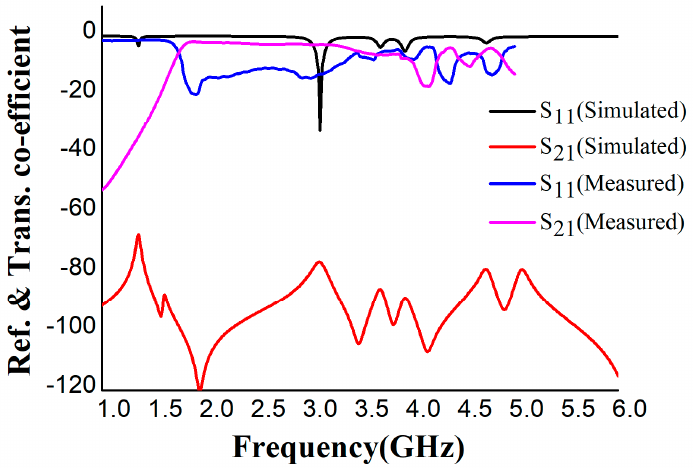
Figure 3. ( a ) Final design steps for unit cell. ( b ) Absorbance at all steps.